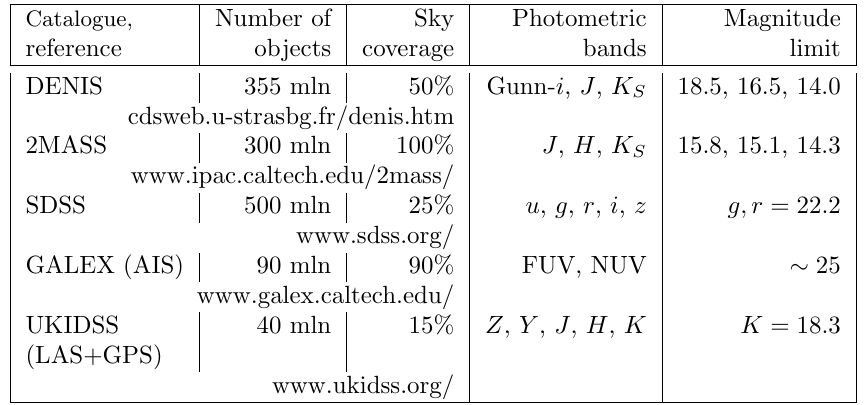
Table 1. Large photometric